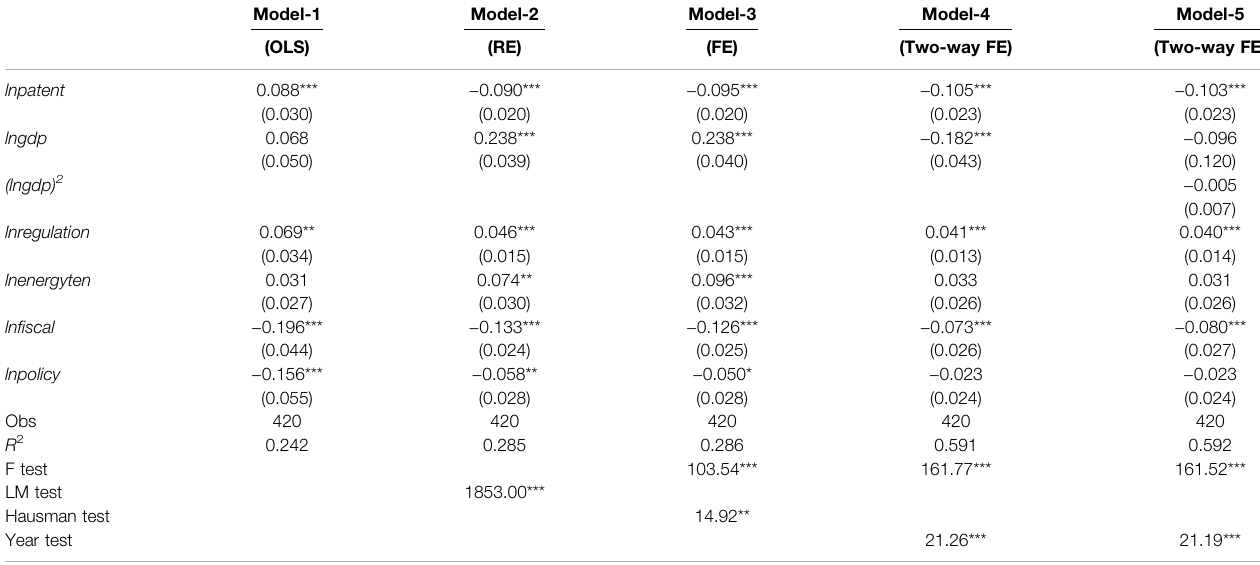
TABLE 2 | Estimation results of panel data